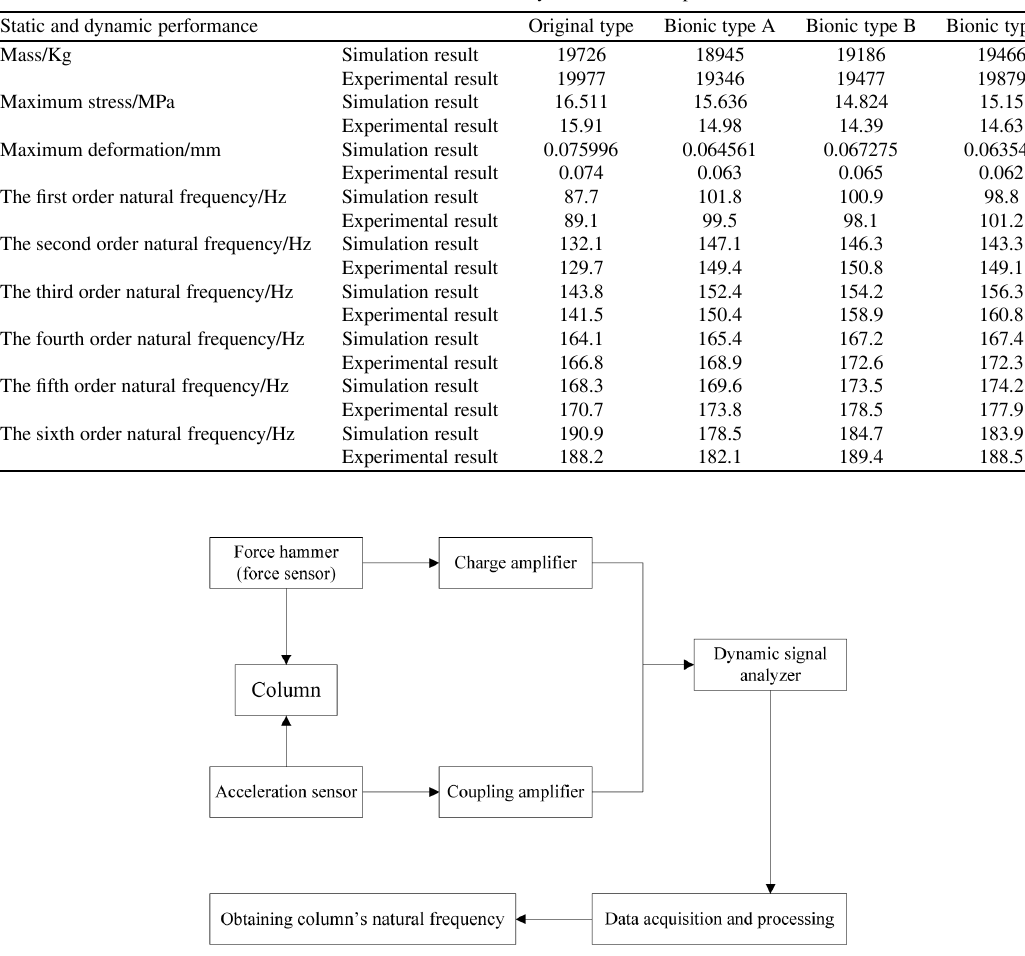
Fig. 14. Principle model of dynamic experiment.